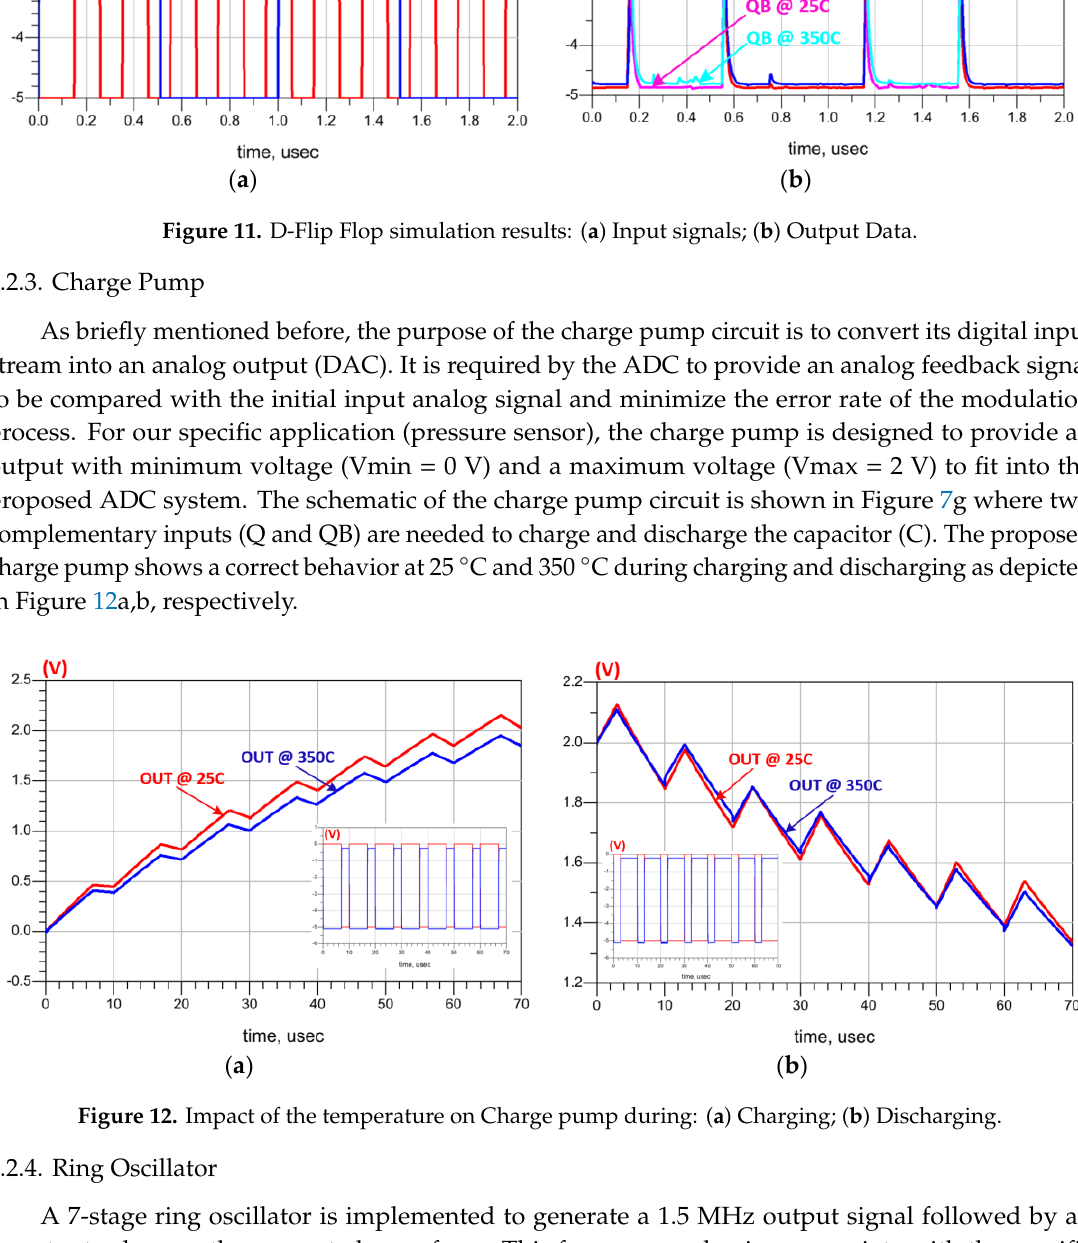
Figure 10. Comparator simulations at different temperatures.